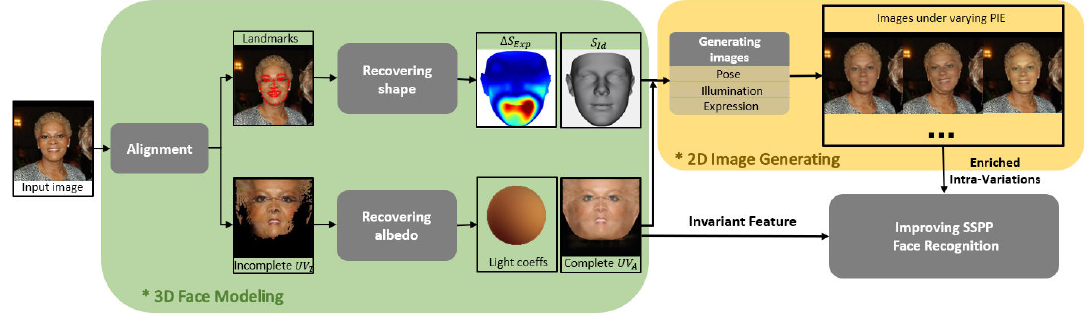
Figure 1. Pipeline of proposed